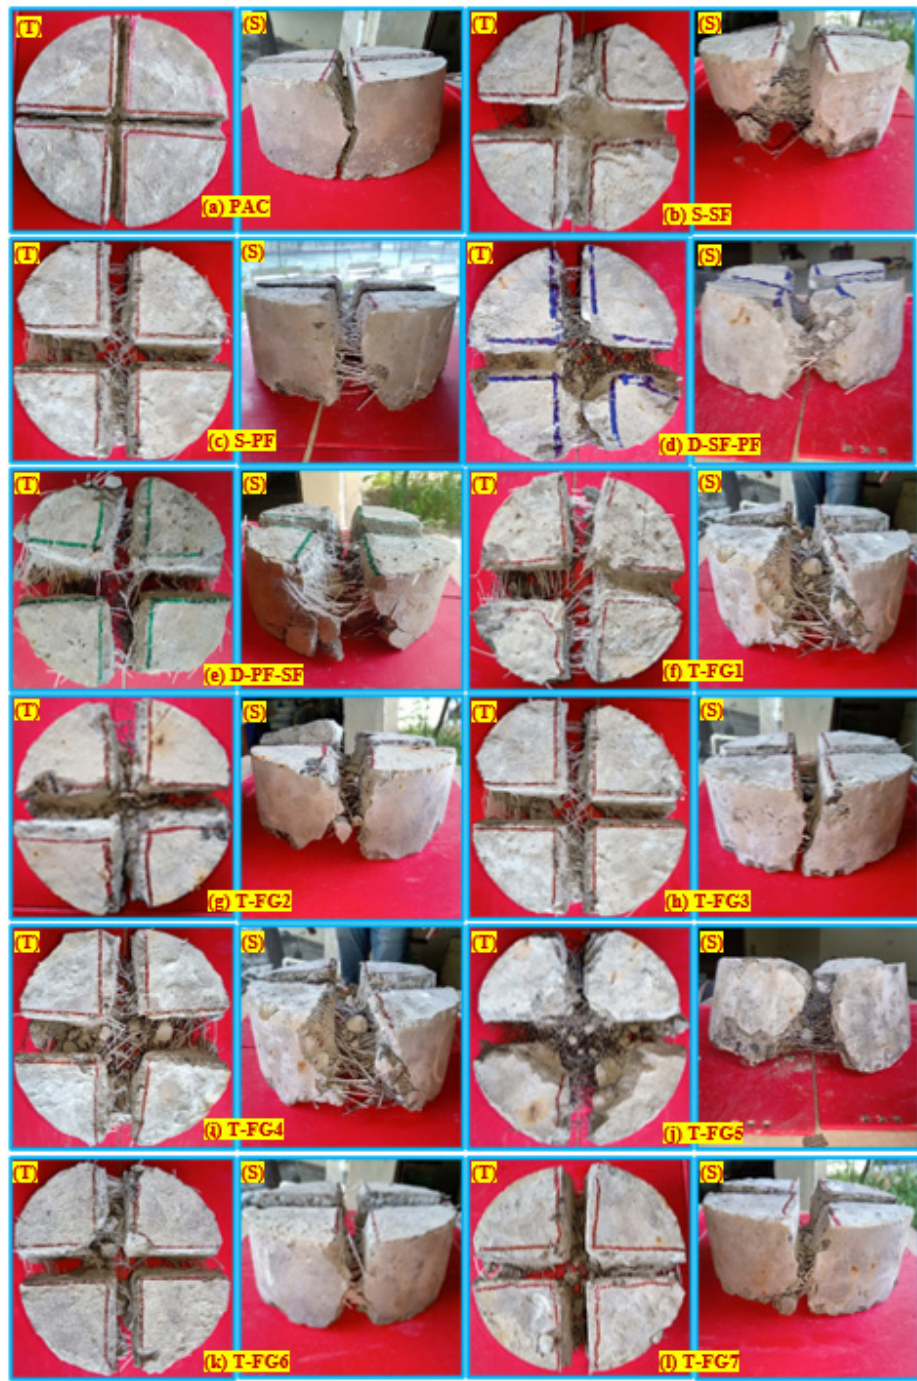
Figure 12. The failure pattern of the specimens under impact loading ( a ) PAC ( b ) S-SF ( c ) S-PF ( d ) D-SF-PF ( e ) D-PF-SF ( f ) T-FG1 ( g ) T-FG2 ( h ) T-FG3 ( i ) T-FG4 ( j ) T-FG5 ( k ) T-FG6 ( l ) T-FG7.